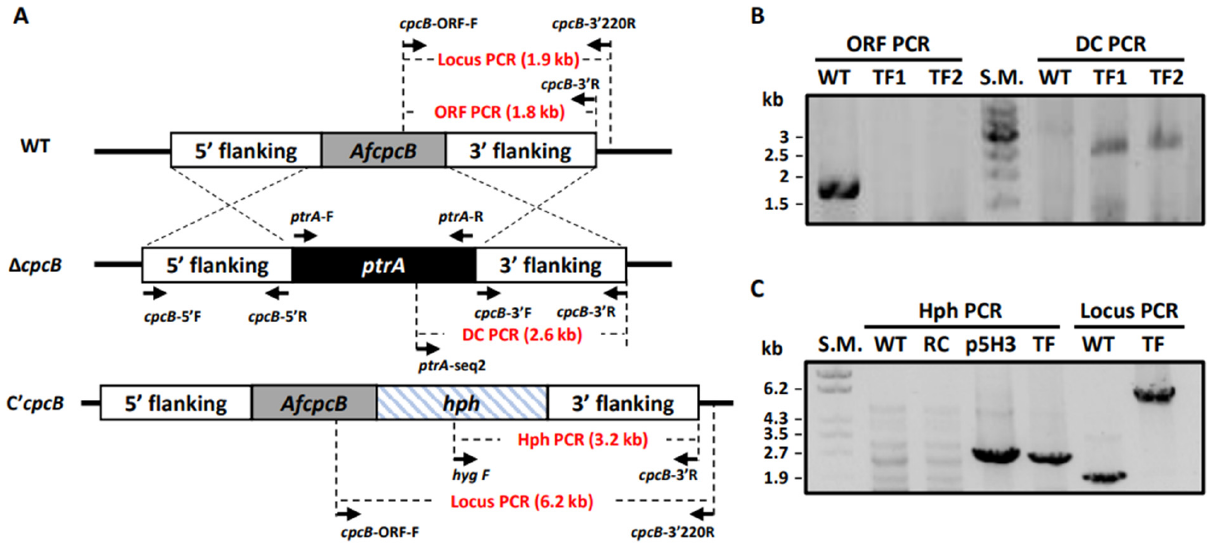
Figure 1. Generation of A. fumigatus cpcB -deletion and complementation stains. ( A ) Schematic illustration of the gene deletion and complementation method. ( B ) PCR confirmation of gene deletion. Genomic DNAs of WT, transformants 1 and 2 were extracted and used as a template for PCR reactions. Open reading frame (ORF) PCR products (1.8 kb) were amplified using AfcpcB -ORF-F and cpcB -3’R. Successful deletion was confirmed by 2.6 kb of disruption cassette (DC) PCR reaction using ptrA -seq2 and cpcB -3’R. Amplified PCR products were separated in a 0.8% agarose gel. ( C ) PCR confirmation of gene complementation. Hph PCR products (3.2 kb) were amplified using hyg F and cpcB -3’R. Locus PCR products (1.9 kb for WT and 6.2 kb for C’ cpcB strain) were amplified using cpcB -ORF-F and cpcB -3’220R. TF, transformant; S.M., size marker; p5H3, plasmid carrying predicted promoter and ORF of cpcB and hygromycin resistance gene.